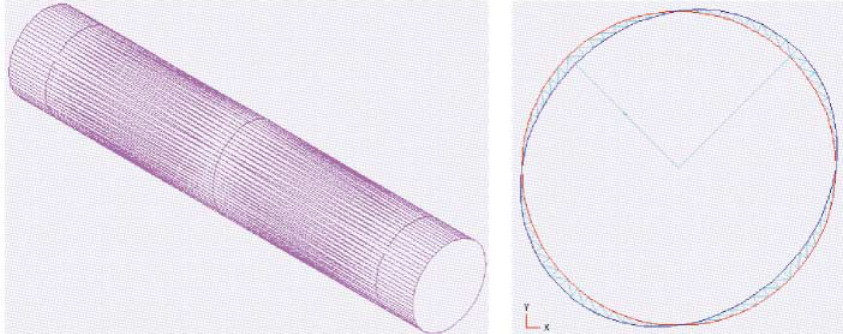
FIG. 20. (Color) Mode rotator geometry and cross section. The two tapers total 22.86 cm. The superposition of the circular cross section of the ends (red) and the central cross section (blue) shows the maximum deformation of 6.8%.